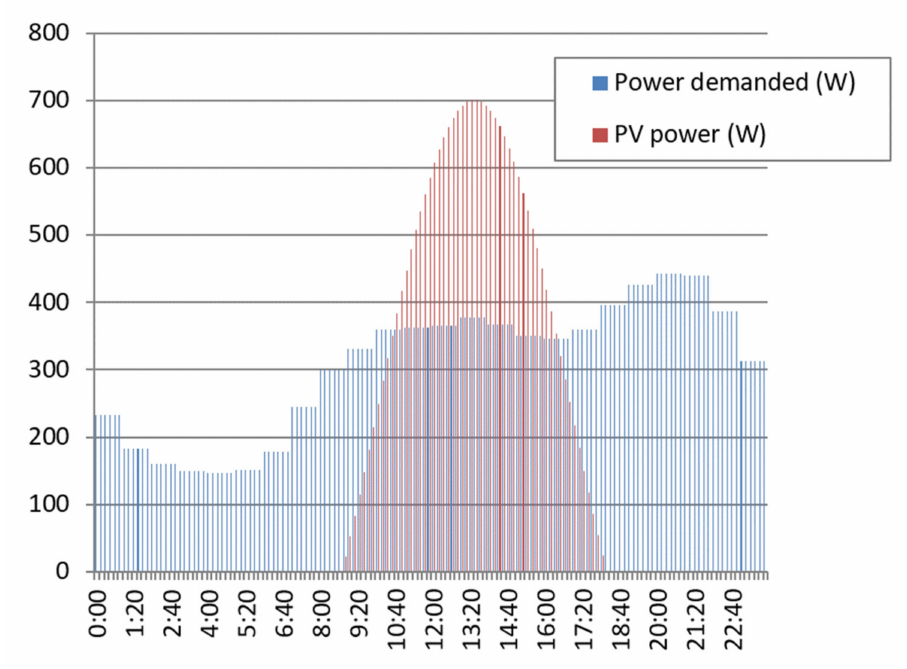
Figure 4. Production-demand curve of a PV installation with